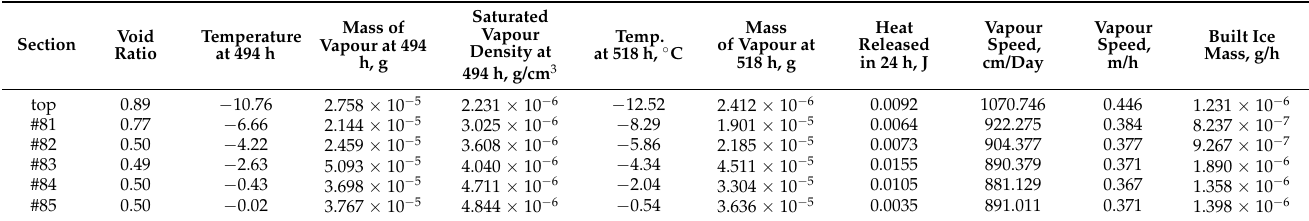
Table A2. Calculation of soil parameters for the 24 h time interval for column #8.